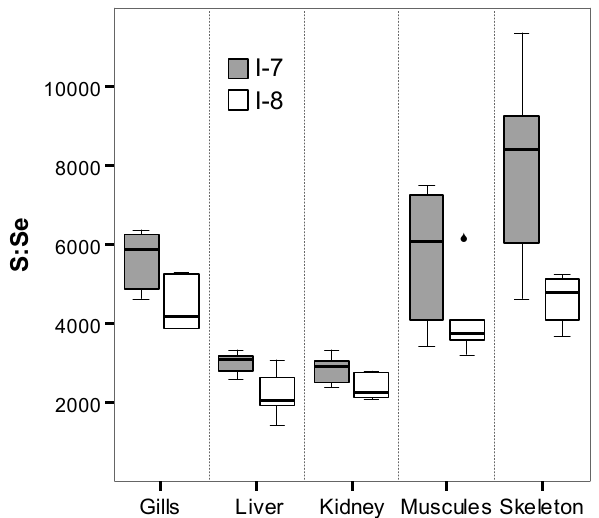
Figure 4. Molar relations of sulfur to selenium (S:Se) in whitefish organs and tissues from the thermal pollution area (I-7) and the natural habitat area (I-8).